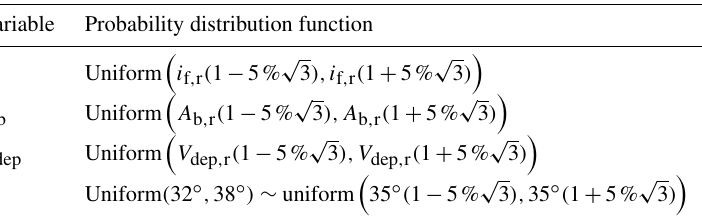
Figure 2. (a) Location of the Trentino-Alto Adige/Südtirol region (Italy) and (b) the Macaion radar and debris-flow events: red dots show all debris flows, while yellow circles highlight the suitable ones for the study. Table 1. Probability distributions of the uncertain variables for each event. i f , r , A b , r and V dep , r are the event reference values of the average slope, the basin area and the deposited sediments